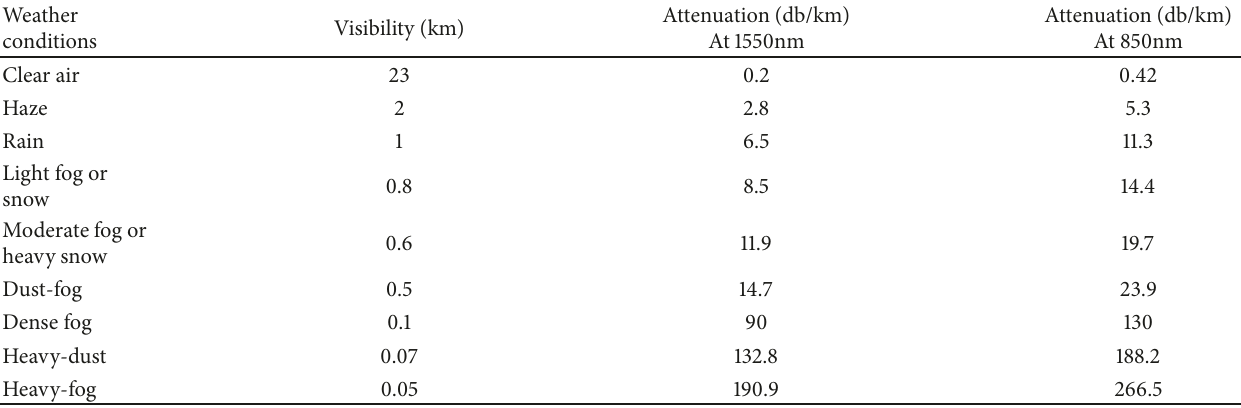
Table 2: Atmospheric attenuation at different weather conditions for 𝜆 = (1550-850) nm using Kruze